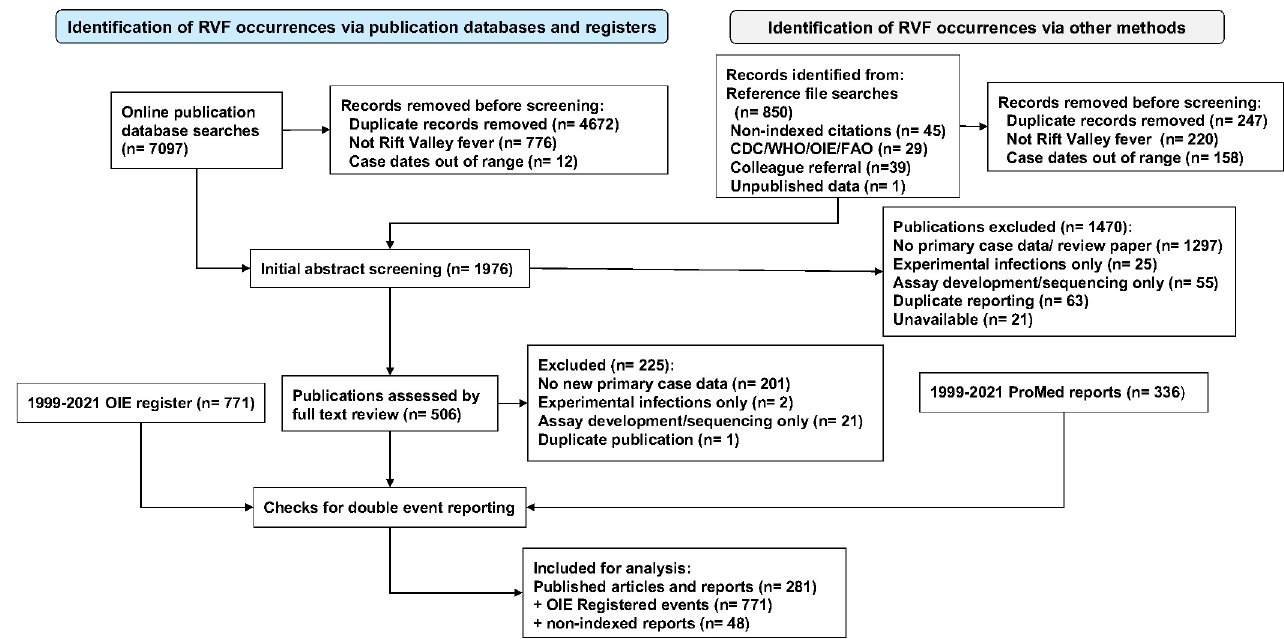
Fig 1. PRISMA systematic review flow diagram of data collection and evaluation. Online searches for publications and data registers (left side flow) were supplemented by governmental outbreak reports, non-indexed citations found in local archives, and citations found within the reference lists of the papers that were reviewed (right side